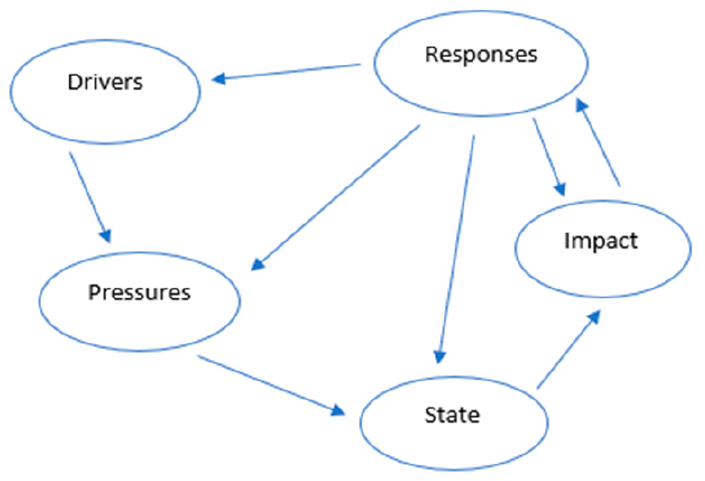
Figure 3. The drivers-pressure-state-impact-response (DPSIR) assessment framework [51].